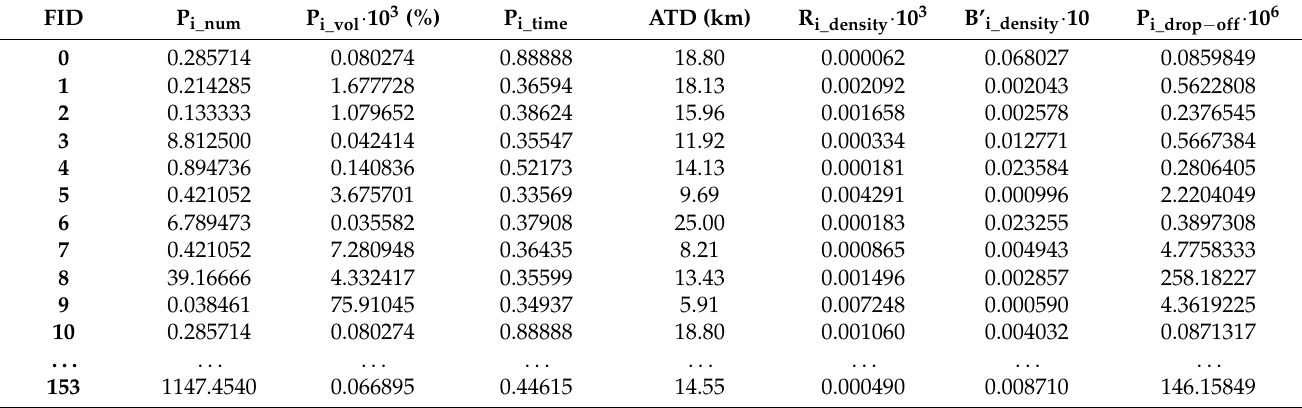
Figure 9. Inflow and outflow of a grid. Table 2. Part of the calculated results of the